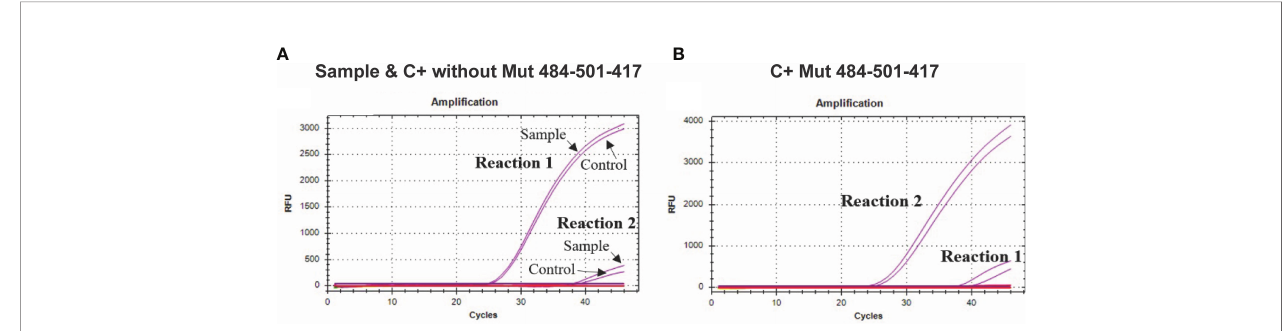
FIGURE 3 | Ampli fi cation curves for the K417N assay. (A) The curves of four independent reactions are shown; the purple curves with a lower Cq value show the forward primer ampli fi cation directed to the sequence without K417N mutation (Reaction 1) in a sample of COVID-19 patients or control C+ without-Mut. In comparison, the signal with a higher Cq value shows the ampli fi cation when using the primer directed to the sequence that presents the mutation (Reaction 2), which presents an evident lag, in comparison to the fi rst reaction. (B) The purple curves with a lower Cq value show the ampli fi cation of the forward primer directed to the K417N mutation (417N Fw) (Reaction 2) using synthetic control C+ Mut484-501-417 (which contains the mutation). In comparison, the ampli fi cation curve with a higher Cq value shows the ampli fi cation when using the primer directed to the sequence that does not present the mutation (Reaction 1) using the same